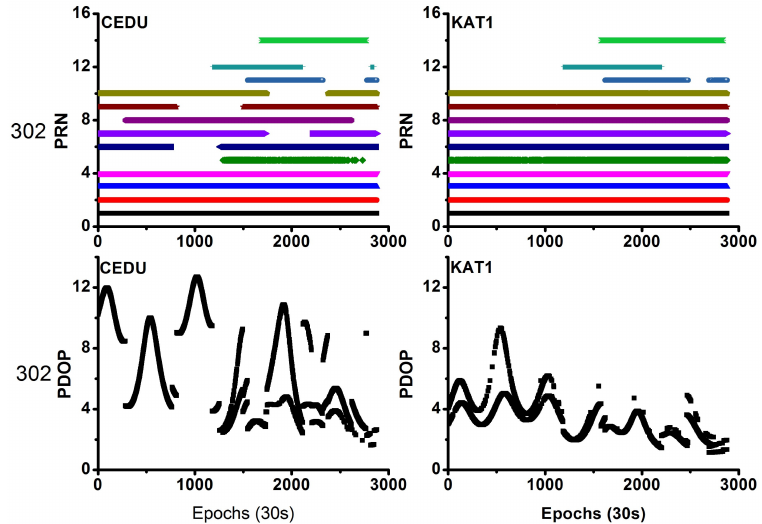
Figure 10. PRN and position dilution of precision (PDOP) values on day 302 ( left side represents CEDU station, and the right side represents KAT1 station).